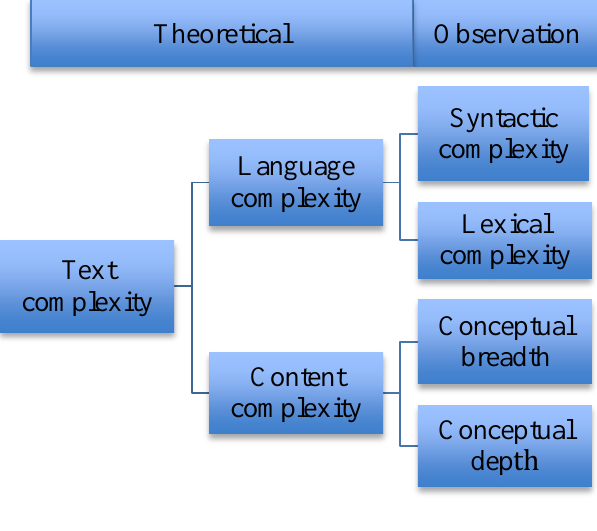
Theoretical and observational conceptualization of text complexity